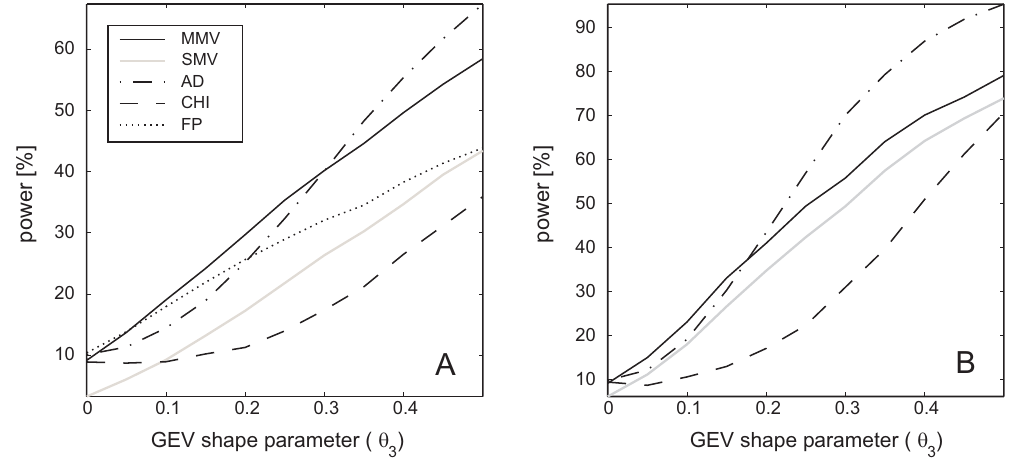
Fig. 1. Power of the tests considered in this paper (MMV=modified maximum value; SMV=standard maximum value; AD=Anderson- Darling; CHI=chi-squared; FP=Fung-Paul) as a function of the shape parameter θ 3 of the parent GEV distribution. The hypothetical distribution is Gumbel, the sample size is n = 20 in panel (A) and n = 50 in panel (B) .